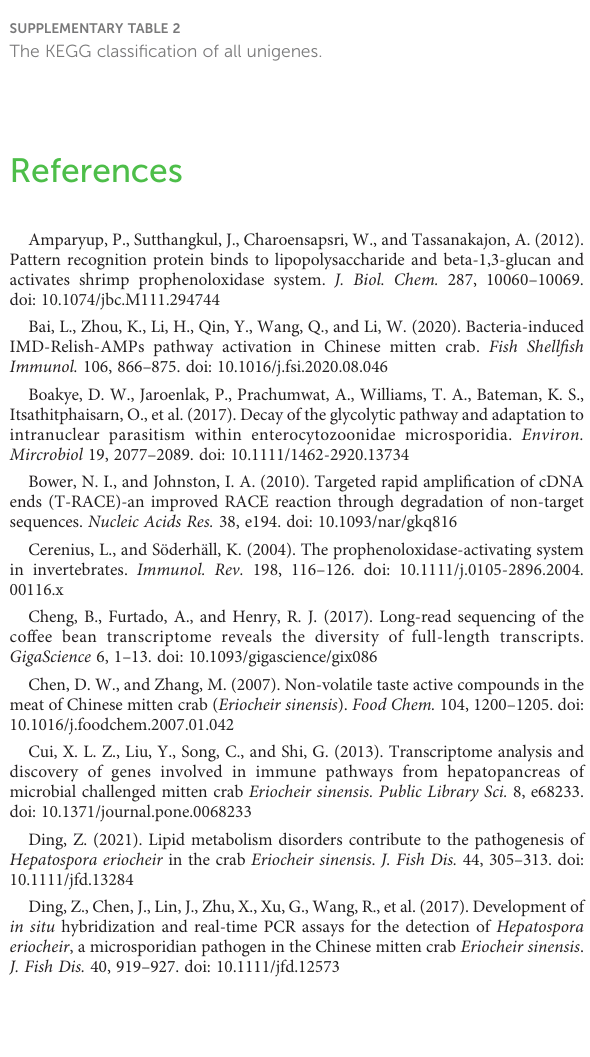
SUPPLEMENTARY TABLE 10 KEGG enrichment analysis of unigenes showing downregulated expression in E. sinensis intestine after H. eriocheir infection. SUPPLEMENTARY TABLE 11 KEGG enrichment analysis of all DEUs in E. sinensis intestine after H. eriocheir